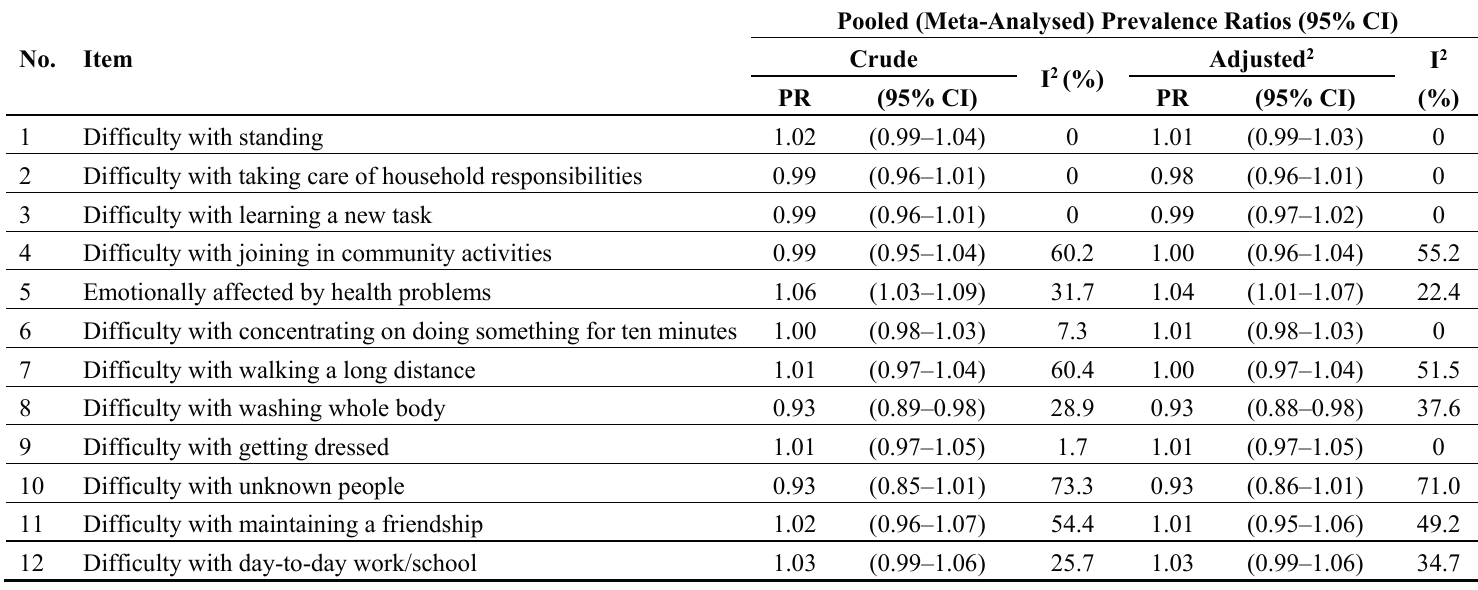
Table 4. Association of individual functioning difficulties (WHODAS-II items) with any community health service use 1 .